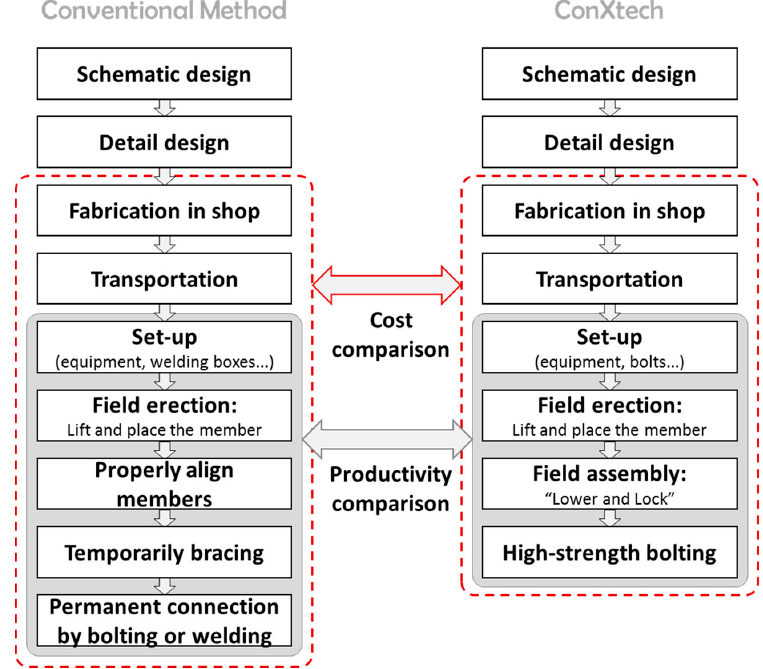
Figure 5. Differences in production process between the conventional structural steel and the ConXtech system.